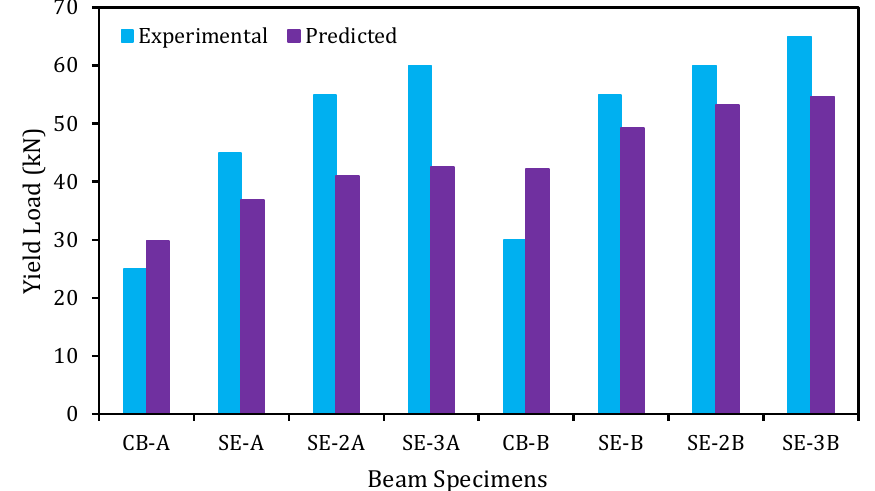
Figure 12. Reduced deflection, compressive, and tensile strains by E-SBR-CFRP fabrics at different loading. ( a ) reduced deflection; ( b ) reduced concrete compressive strains; ( c ) reduced steel rebar tensile strains